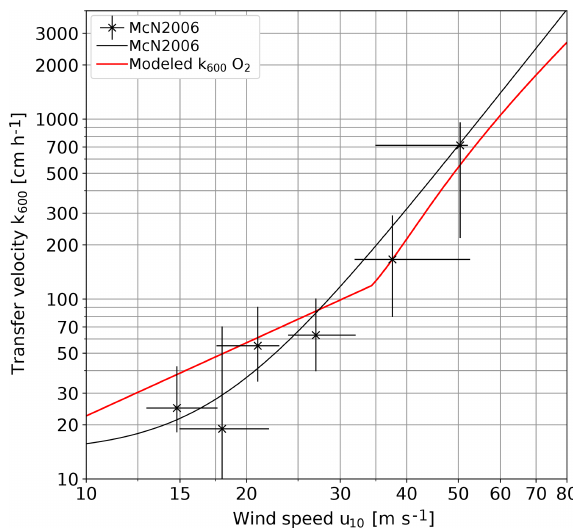
Figure 10. Measured transfer velocities of DMS, scaled to k 600 , compared to previous field studies. Bell: Bell et al. (2017); Blom: Blomquist et al. (2017); Zav: Zavarsky et al. (2018).